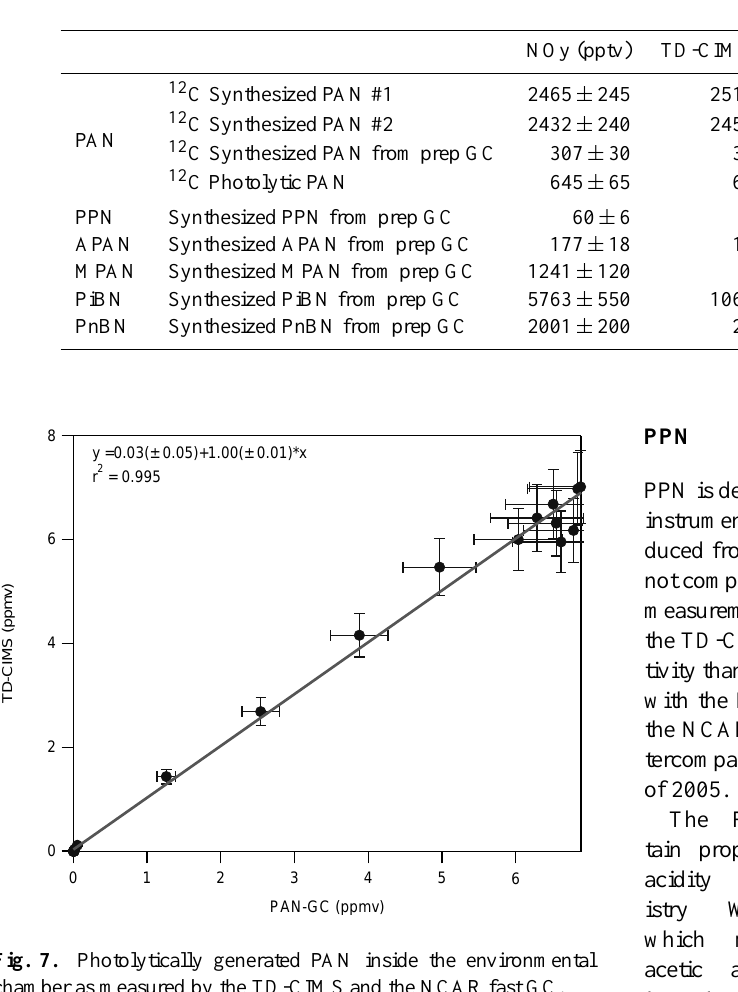
Table 2. Comparison between TD-CIMS and NO y instrument.